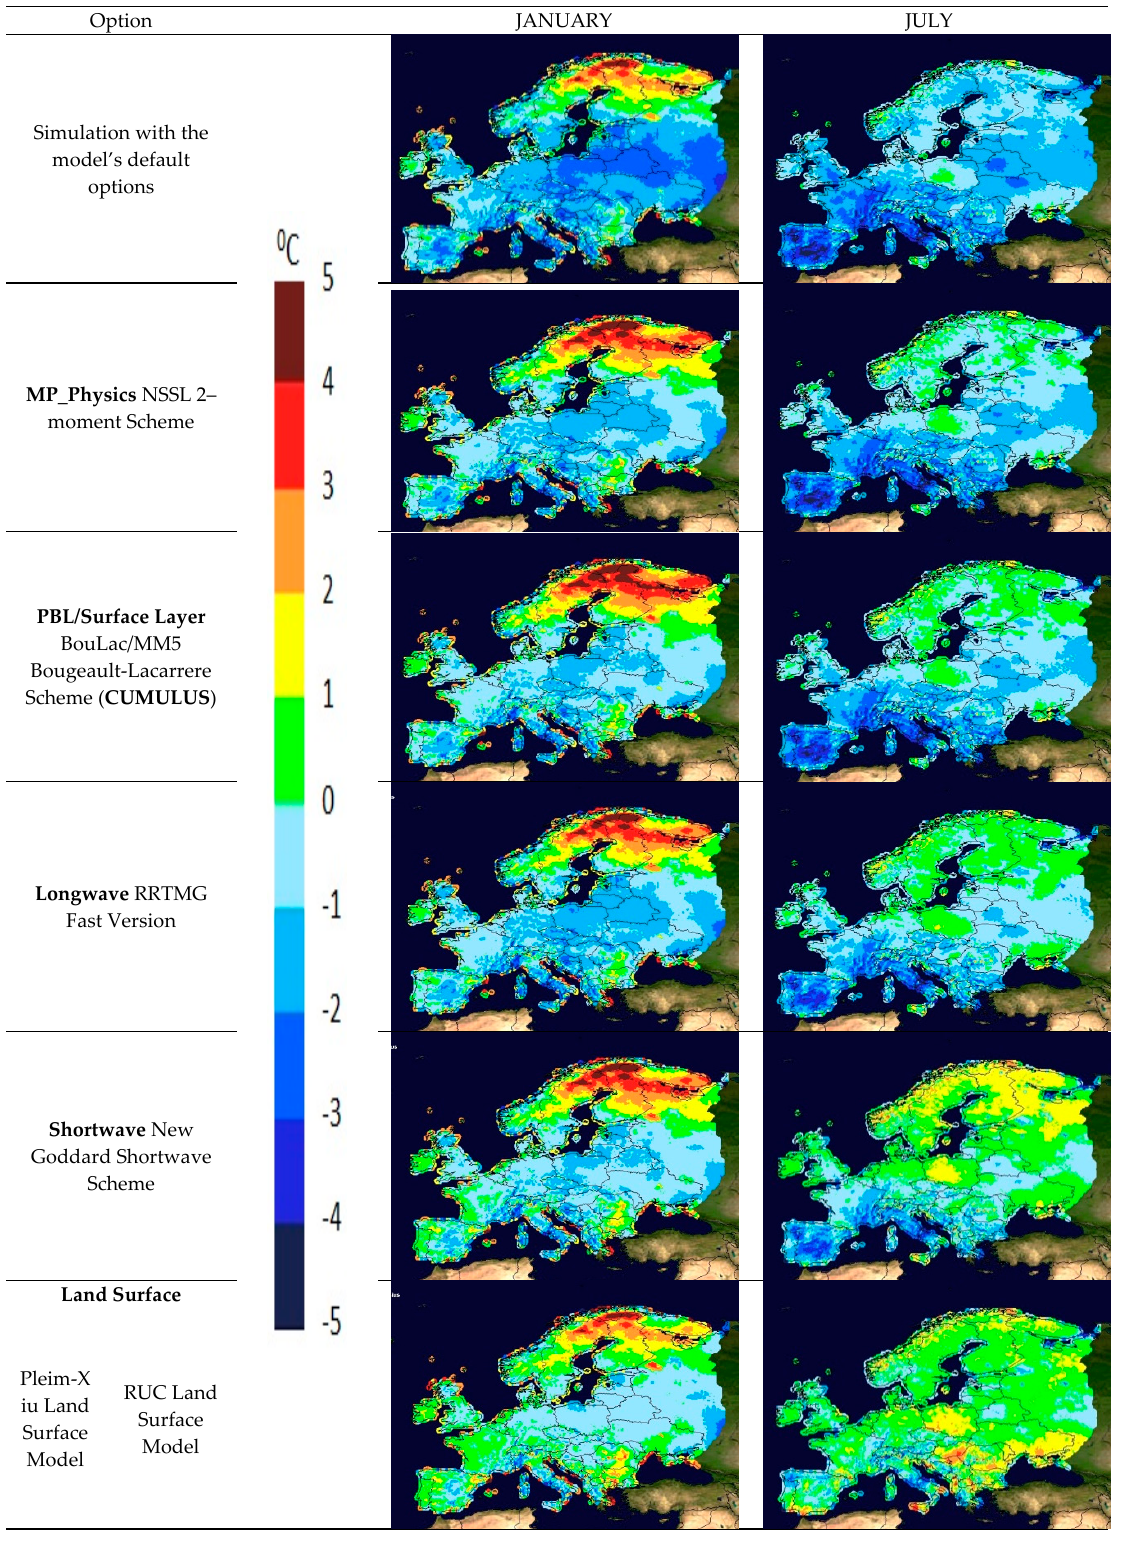
Figure 3. Temperature Mean Bias spatial distribution after each simulation